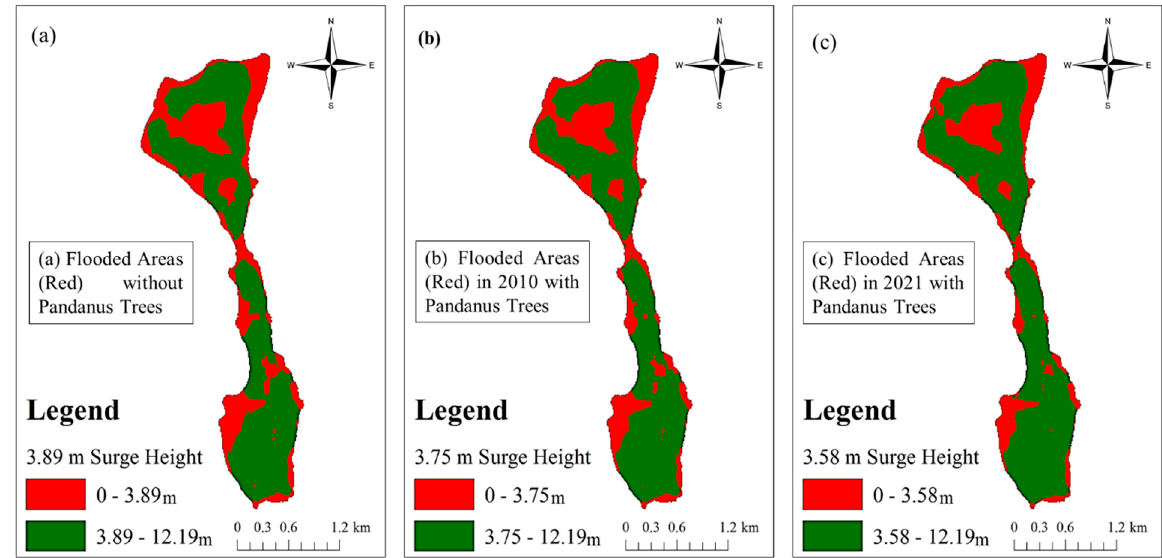
Figure 7. Flooded areas: ( a ) without Pandanus trees; ( b ) with the Pandanus trees present in 2010; ( c ) with the Pandanus trees present in 2021.